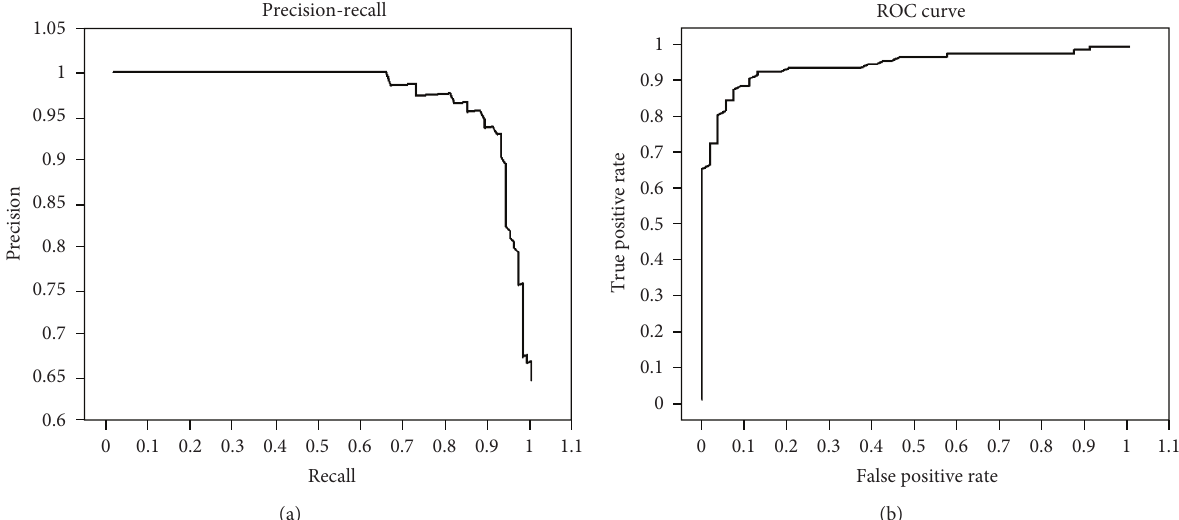
F 4: Precision-recall and ROC curves for the support vector machine